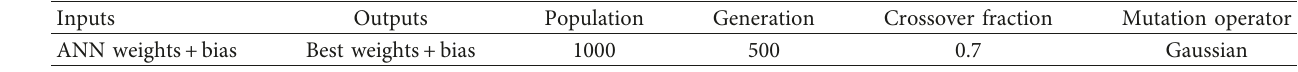
Table 5: Parameters of GA-Toolbox model.